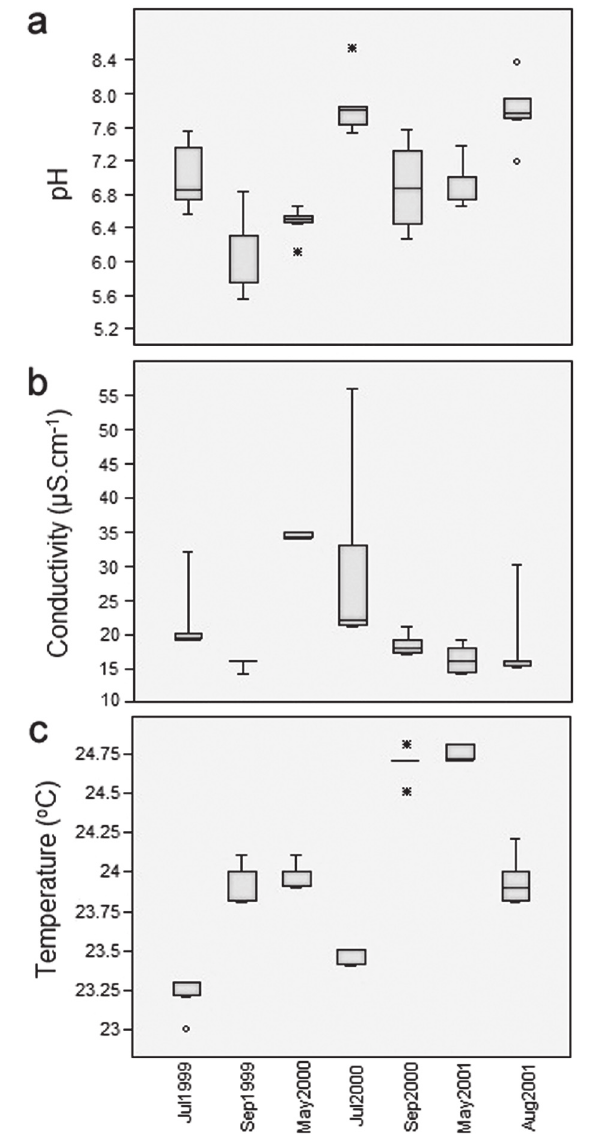
Fig. 7 . Box-plots showing means and standard deviations of pH ( a ) conductivity ( b ) and temperature ( c ) from the São Vicente II cave stream in the dry seasons of 1999, 2000 and 2001 (circle and asterisk represent